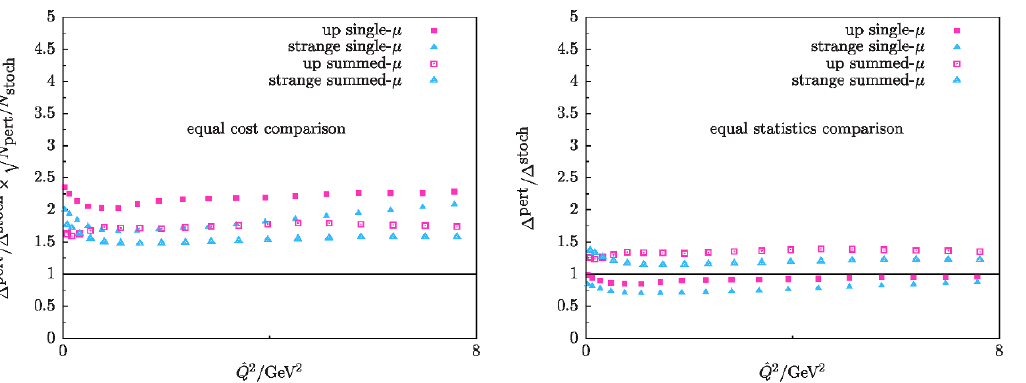
Figure 14 . Ratio of statistical errors of perturbative and stochastic data. The plot on the left shows an equal cost comparison, the plot on the right shows an equal statistics comparison. Closed and open symbols refer to the single- or summed- (cid:22) insertion technique for the perturbative method, re- spectively. Purple squares show results for the up quark, blue triangles results for the strange